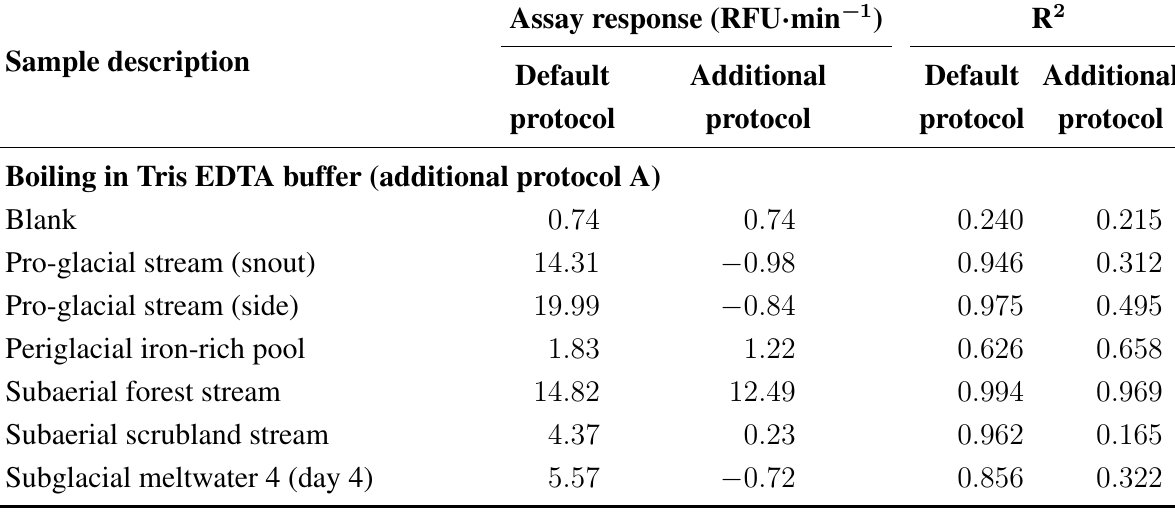
Table 1. Assessment of two additional sample processing protocols for LPS determination in glacial samples when compared to the use of the minimal sample processing protocol. Note that all assay responses are derived from samples analysed in